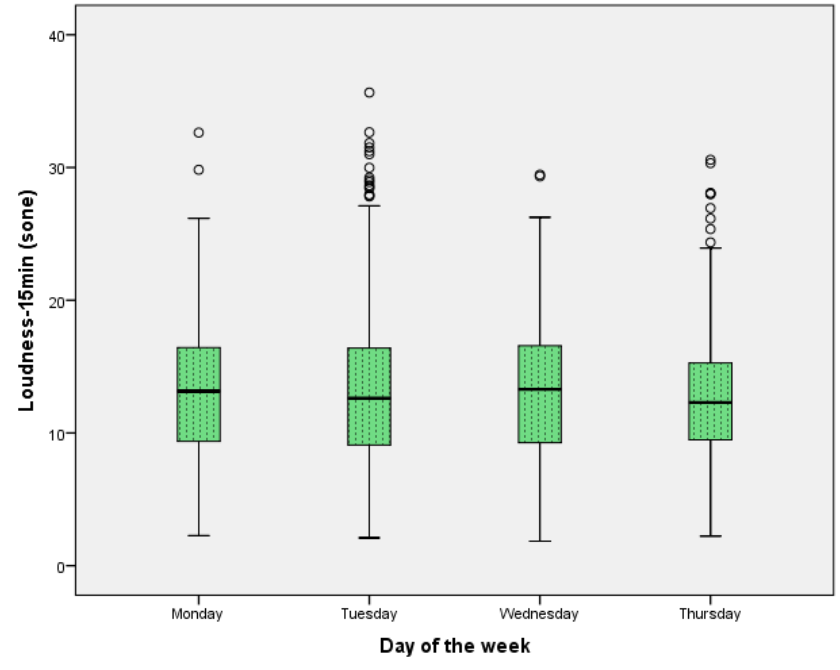
Figure 6. Distributions of Loudness -15min scores as a function of the day of the week.